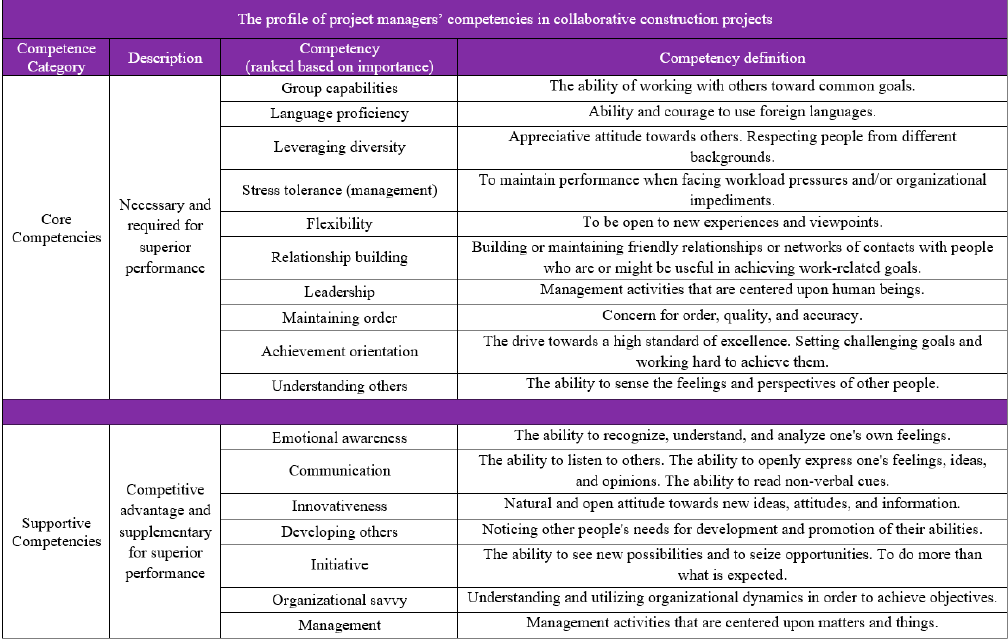
Figure 7. The profile of project managers’ competencies in collaborative construction projects.